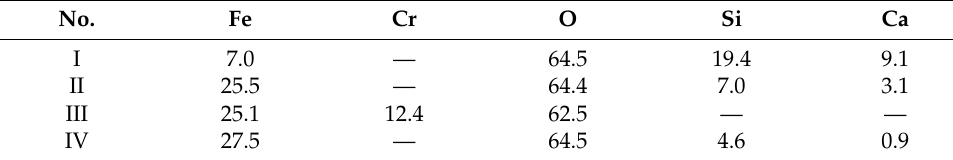
Figure 2. Effects of the Cr 2 O 3 content of the microstructure of CaO-SiO 2 -Fe t O system. The numbers 1–3 in the figures represent the phases CaFeSi 2 O 6 , Fe 3 O 4 and Fe(Fe,Cr) 2 O 4 , respectively. Samples A0 to A5 correspond to ( a – f ), respectively. The SEM mapping of area “A” in (d) is shown in Figure 3. The SEM mapping of area B and line “a” in (e) are shown in Figure 4. The EDS analysis results of points I , II , III, and IV in (d) are shown in Table 3. Table 3. The EDS analysis results of each point in Figure 2d, at%.